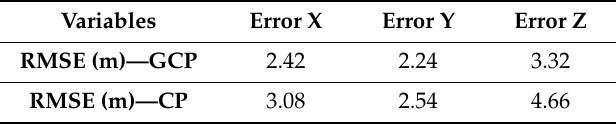
Table 5. RMSE values referring to the 75 GCP and 25 CP dataset.